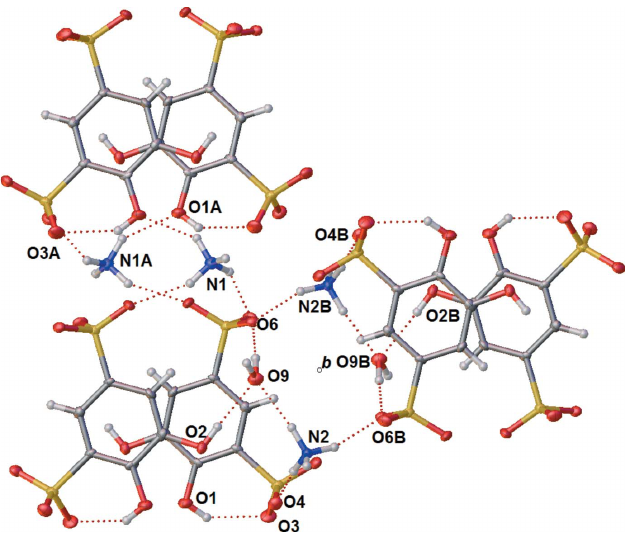
Figure 9 Displacement ellipsoid plot of (NH 4 ) 2 (tiron) (cid:2) H 2 O showing neighboring H-bonding interactions among six tiron anions, four ammonium ions, and two water solvate molecules. Ellipsoids are shown at the 50% probability level and hydrogen atoms are shown as open spheres. Atom labels with the suffix B are generated by symmetry about a crystallographic center of inversion (Wyckoff position b ), and atom labels with the suffix A are generated by one or more glide operation.